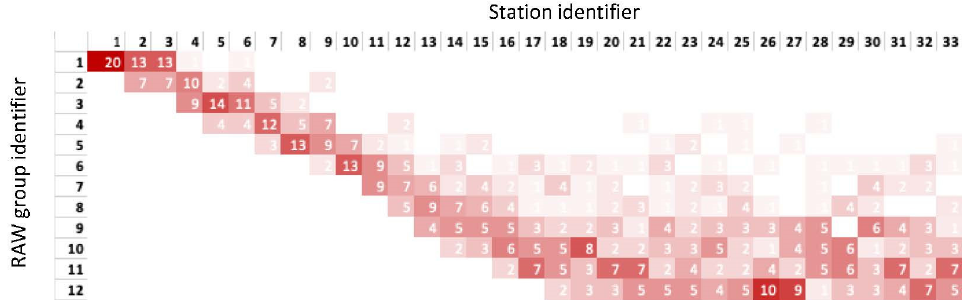
Figure 9. Heat map representing the frequency with which the GA assigns STAs to different groups ( G = 33 STAs, R = 12 RAW groups). Table 1. Alternatives for initial population.